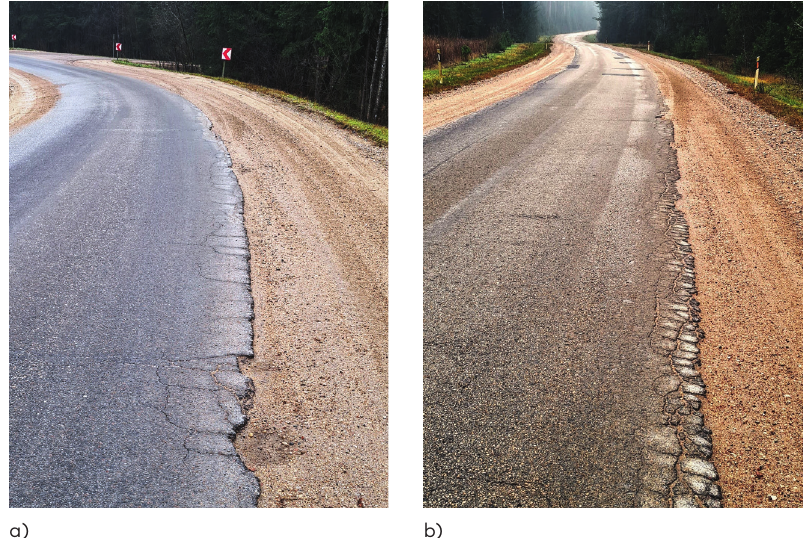
Figure 1. Risky horizontal road curves on the pavement with edge